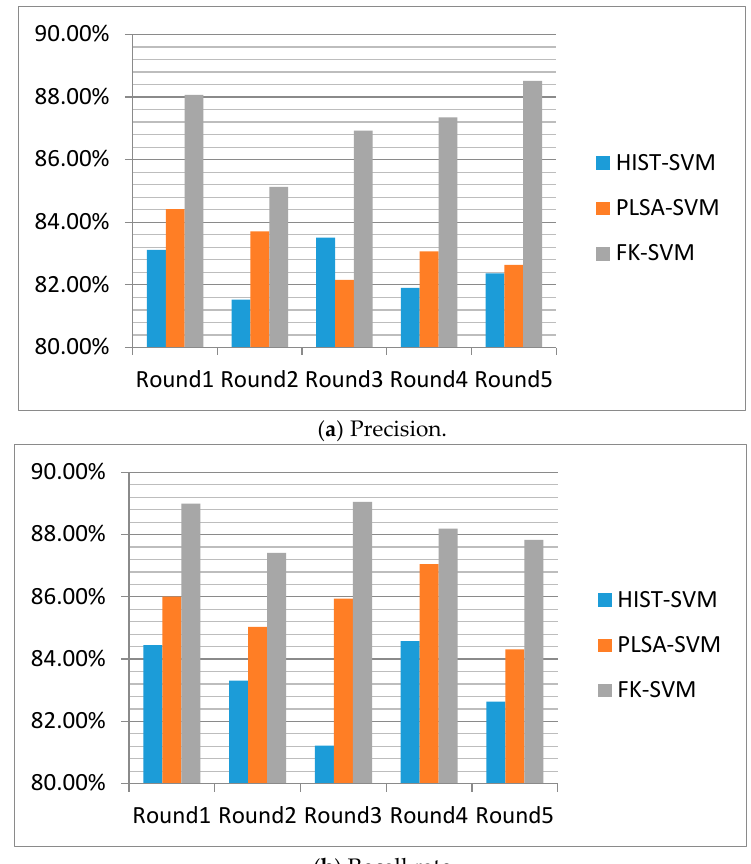
Figure 2. The multi round compared experimental results of FK-SVM, HIST-SVM and PLSA-SVM. ( a ) Precision. ( b ) Recall rate.